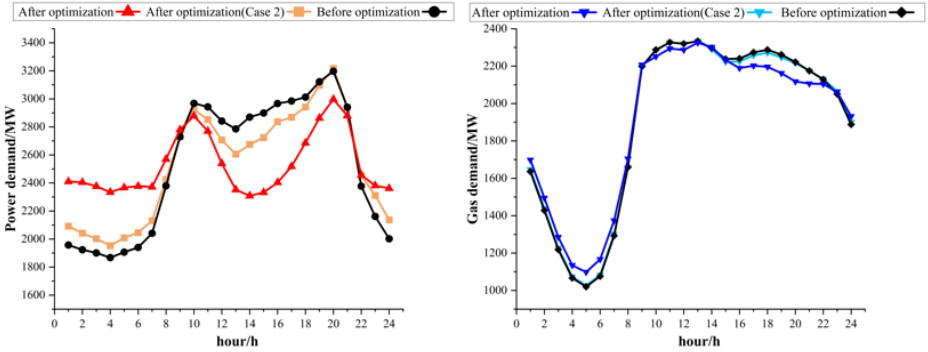
Figure 15. The power/gas demand before and after the optimization in Case 1 and Case 2.